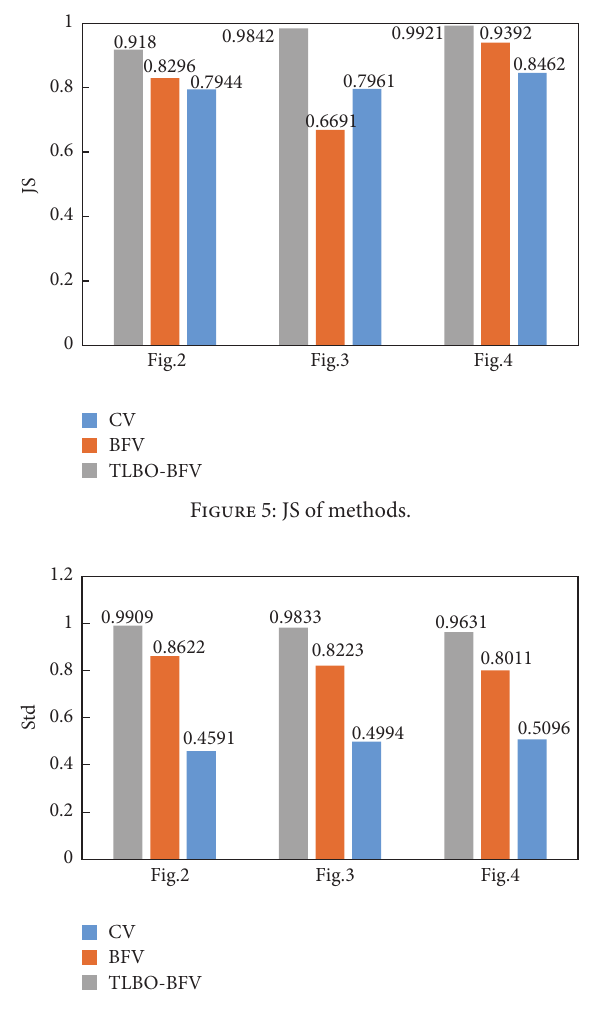
Figure 6: Standard deviation of methods.